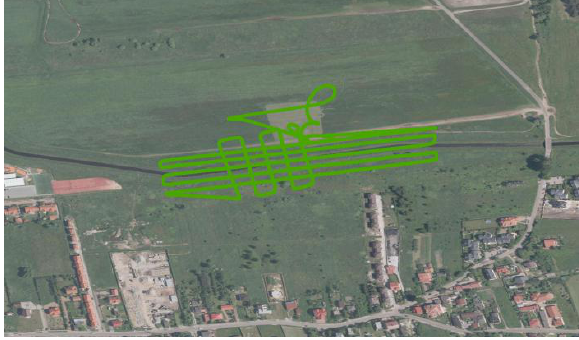
Figure 7. The example trajectory of the test flight